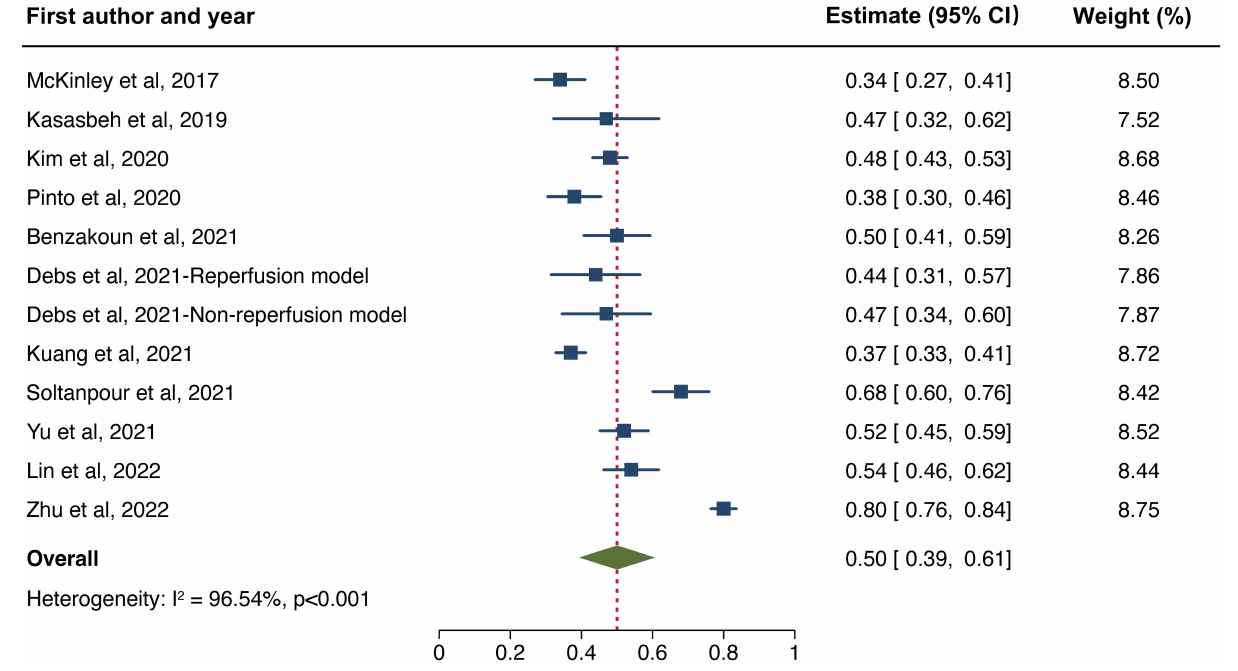
FIGURE 2 | Forest plot of the included studies that assessed the performance of infarct tissue outcome prediction. Forest plot shows that the dice similarity coefficient (DSC) representing the performance of the machine learning-based approaches for final infarct prediction centers around 0.50 with a 95% confidence interval (CI) ranging from 0.39 to 0.61.